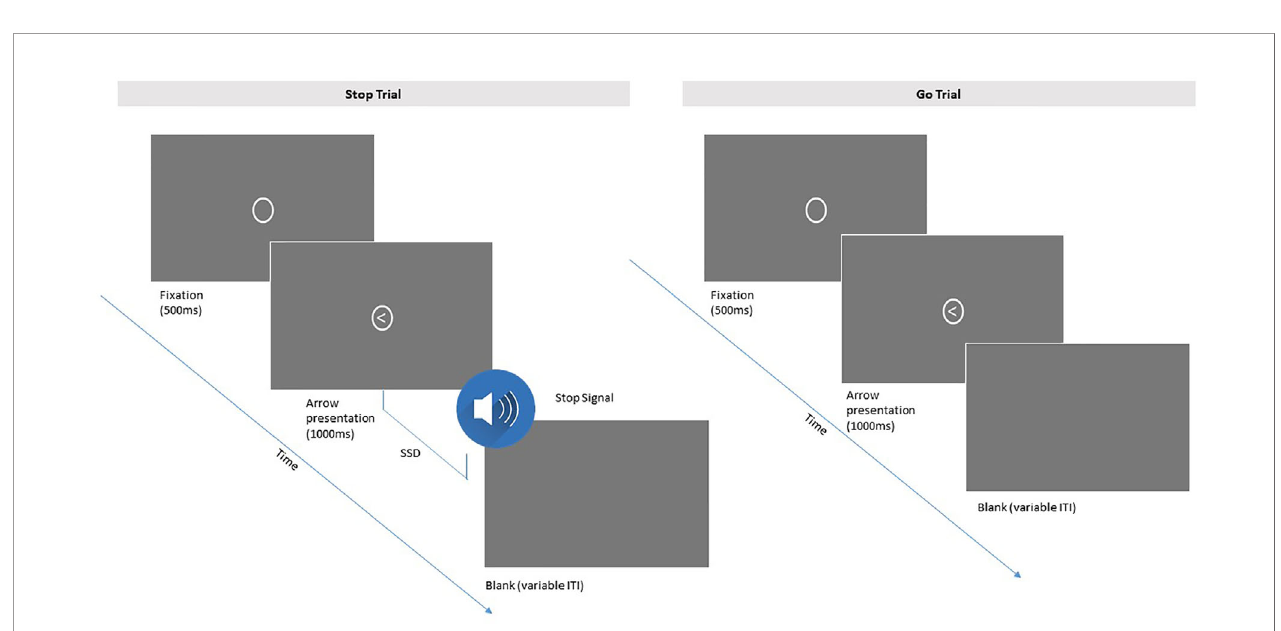
FIGURE 5 | Depiction of the Stop Signal Task sequence for parents. Participants press the arrow on a keyboard that corresponds to the direction of the arrow in each trial. Participants are instructed to withhold a response when an auditory stop signal is played immediately after the go signal at a variable latency (SSD, stop signal delay; ITI, intertrial